Question: Give a one-sentence summary of this figure.
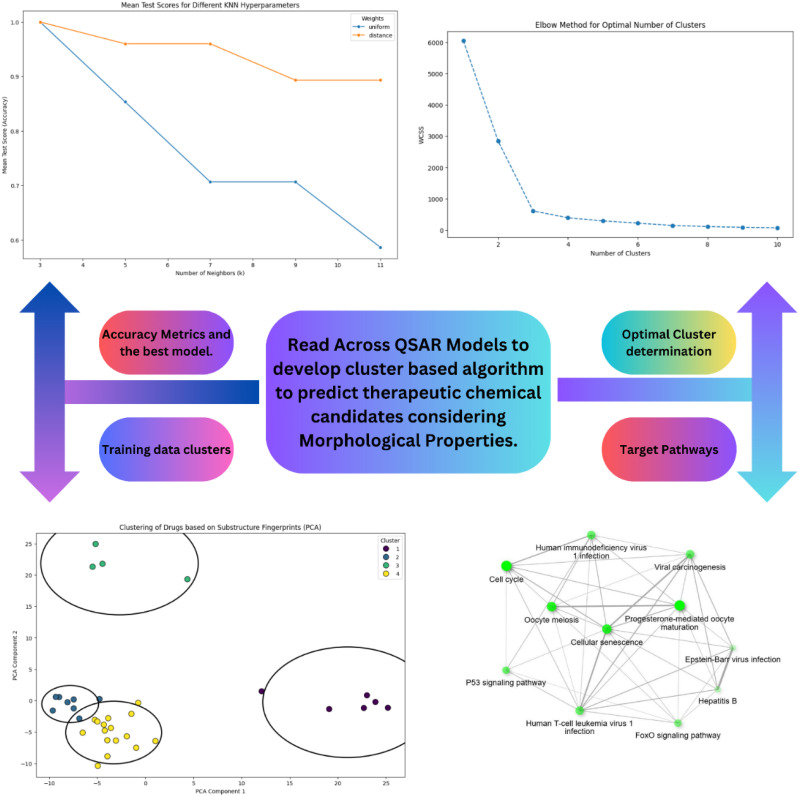
Answer: RASAR model to analyze the therapeutic drugs based on their morphological parameters and analyze the clustering based on the similarity of structural parameters among the chemical candidates. Additionally, we also included the accuracy metrics and model selection graph with the target biological pathways potentially involved with the MoA of the respective drugs